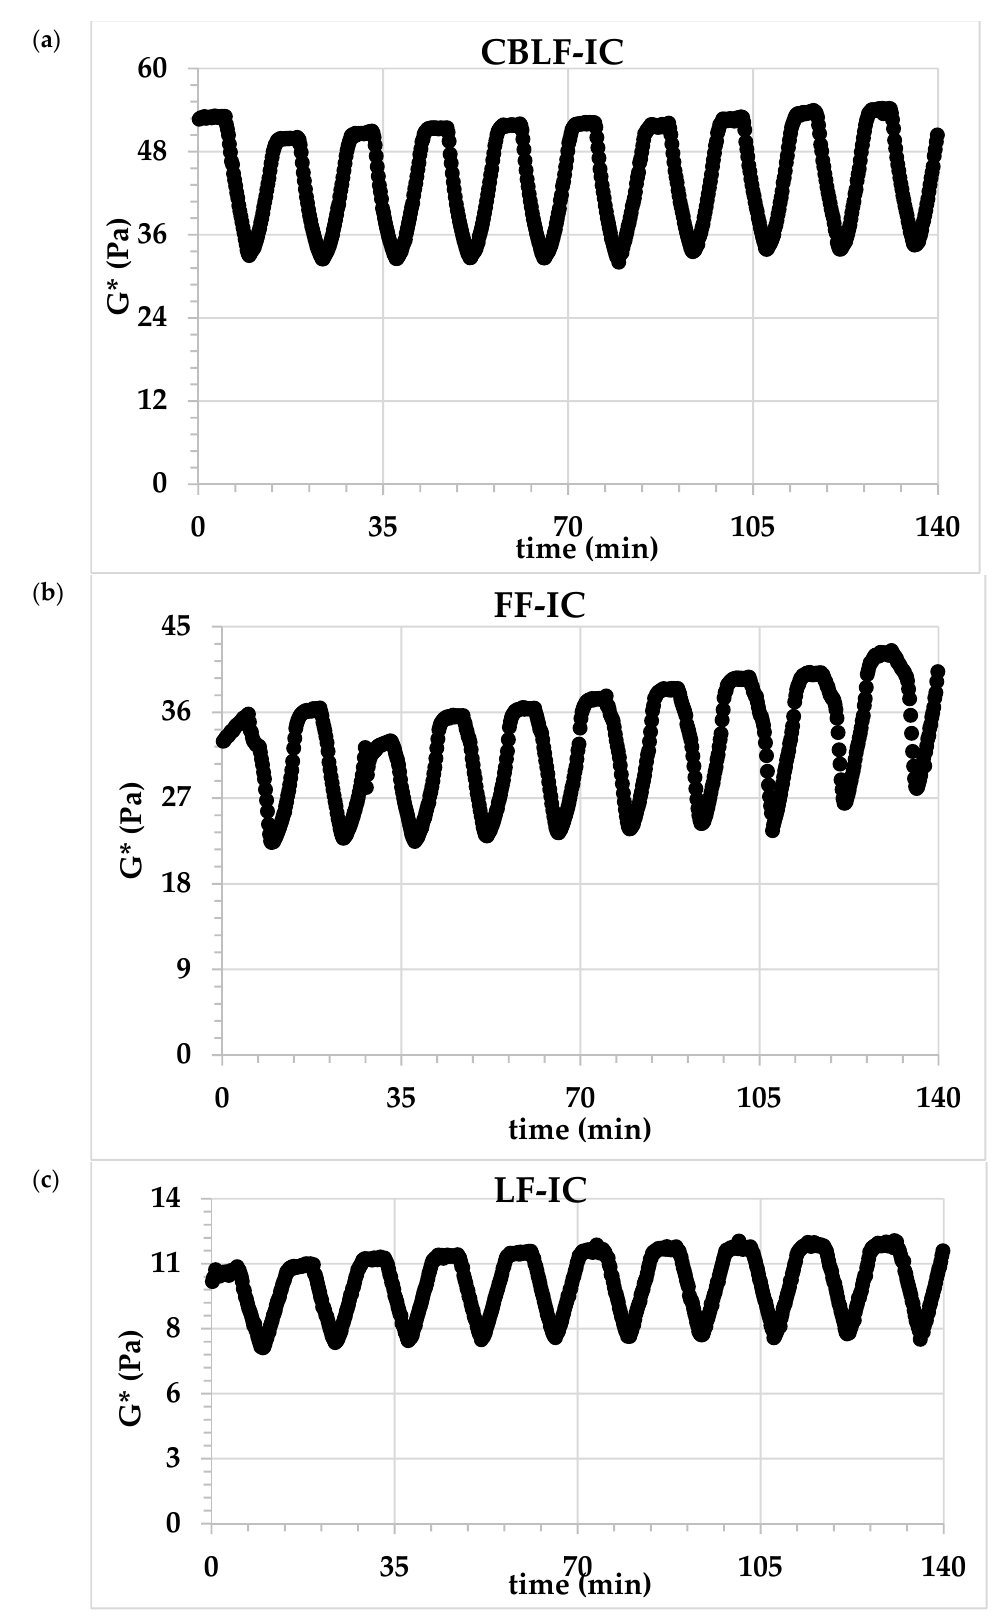
Figure 6. The change in the G* value after applying the thermal loop. ( a ) CBLF-IC: low-fat ice cream with chia seed oil by-product, ( b ) FF-IC: full-fat ice cream, ( c ) LF-IC: low-fat ice cream.